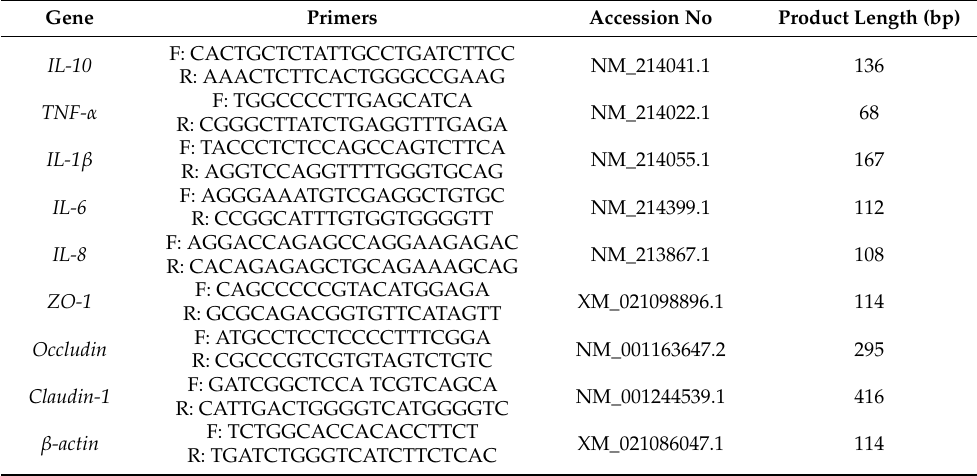
Table 2. Primer sequences used in this study.